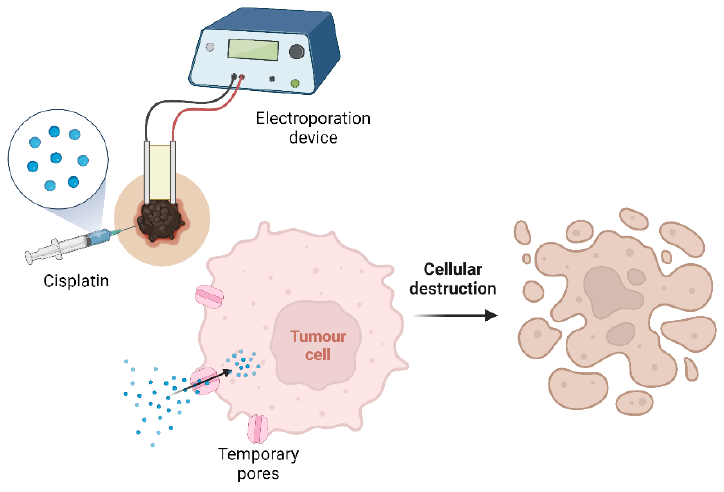
Figure 3. Electrochemotherapy procedure (created with BioRender.com).